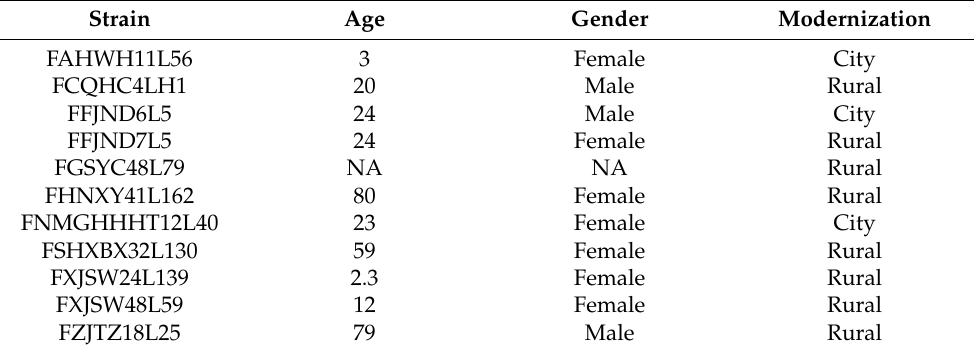
Table 2. Host Information of 11 New Isolated L. acidophilus .